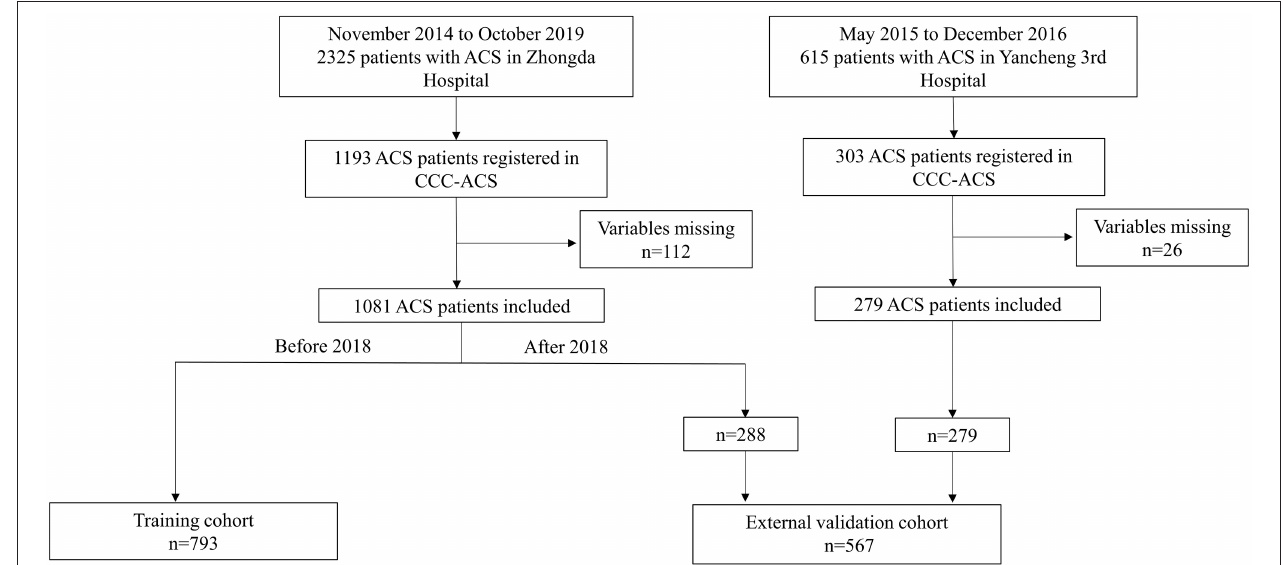
FIGURE 1 | Study flow chart. Patients from Zhongda Hospital and Yancheng Third People’s Hospital were included in the study. The enrolled study population was divided into a training cohort and a validation cohort. ACS, acute coronary syndrome; CCC, Improving Care for Cardiovascular Disease in